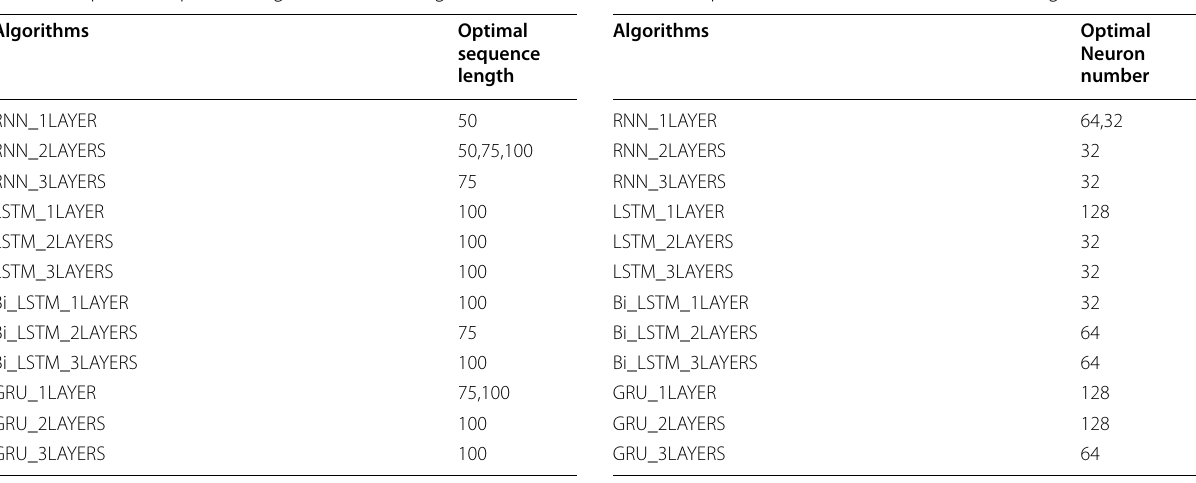
Table 6 Optimal Neuron number for different